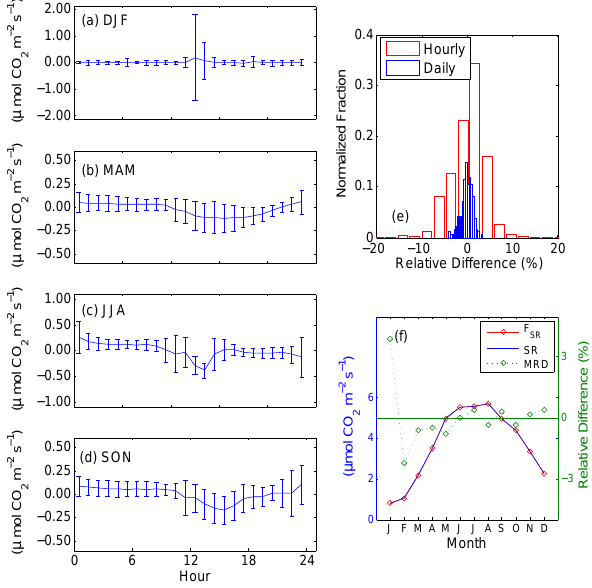
Fig. 8. A comparison of surface CO 2 effluxes and their produc- tion rates at different temporal scales. (a) , (b) , (c) , and (d) show the hourly difference between surface CO 2 efflux ( F SR ) and their corresponding soil respiration (SR) averaged for different three- month periods. (e) Histograms of the relative differences (( F SR − SR )/F SR × 100%) at hourly and daily time steps. (f) Comparison of monthly time step time series of surface CO 2 effluxes and soil respiration. MRD represents the monthly relative difference. See text for details of the